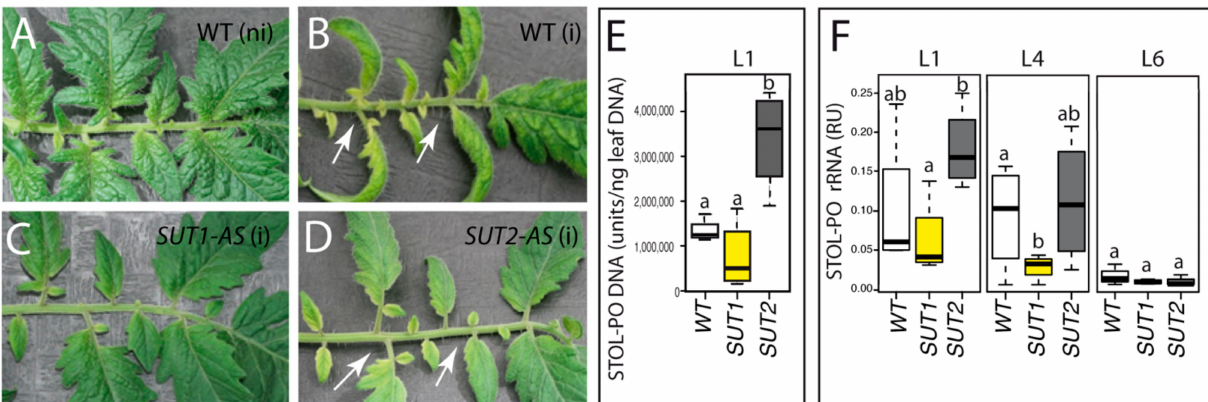
Figure 2. Symptoms and Stolbur phytoplasma proliferation in infected plants. ( A – D ) Details of L1 leaves from grafted noninfected wild-type (WT) ( A ), infected WT ( B ), infected SUT1 -AS (antisense) ( C ) and infected SUT2 -AS ( D ). ni: non- infected and i: infected ( D ). White arrows in ( B , D ) indicate leaf typical yellowing and growth reduction. ( E , F ) Boxplot showing phytoplasma DNA in L1 leaves in ( E ) and rRNA amounts in L1, L4 and L6 leaves in ( F ); RU: relative units of content. The box and whisker plots in ( E , F ) show the distribution of the biological replicates. Inside black lines represent medians; top and bottom ends of the boxes represent the first and the third quartiles, respectively; n = 4. Different letters denote statistically different values determined by ANOVA and Tukey’s